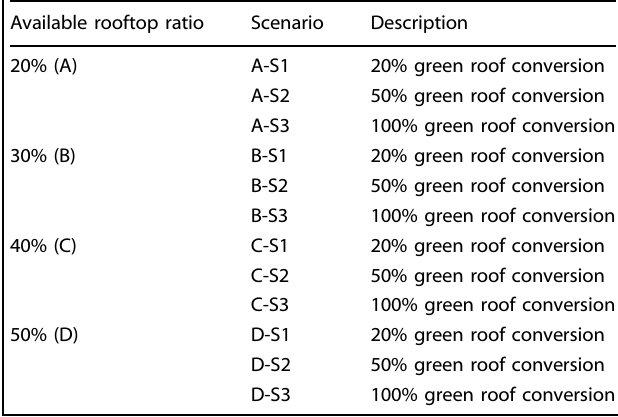
Table 1. Scenario settings of urban green roof